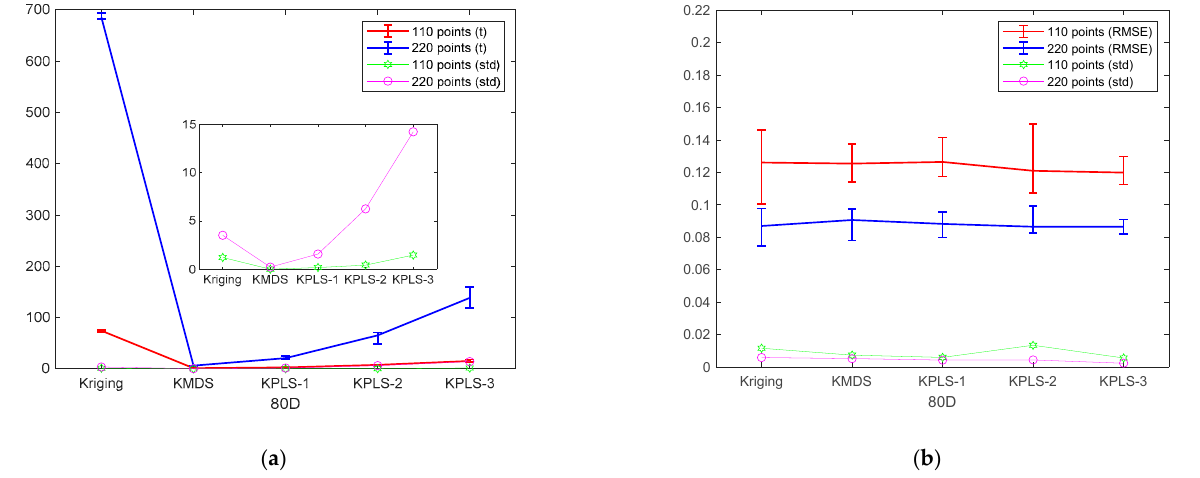
Figure 12. ( a ) Modeling time and its standard deviation for the 80D Michalewicz function. ( b ) RMSE and its standard deviation for the 80D Michalewicz function.